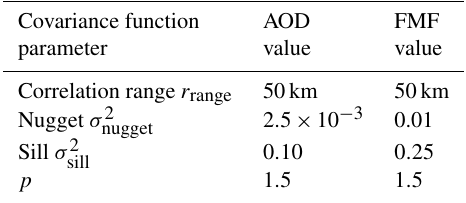
Table 1. The covariance function parameters used in aerosol optical depth (AOD) and fine-mode fraction (FMF) prior